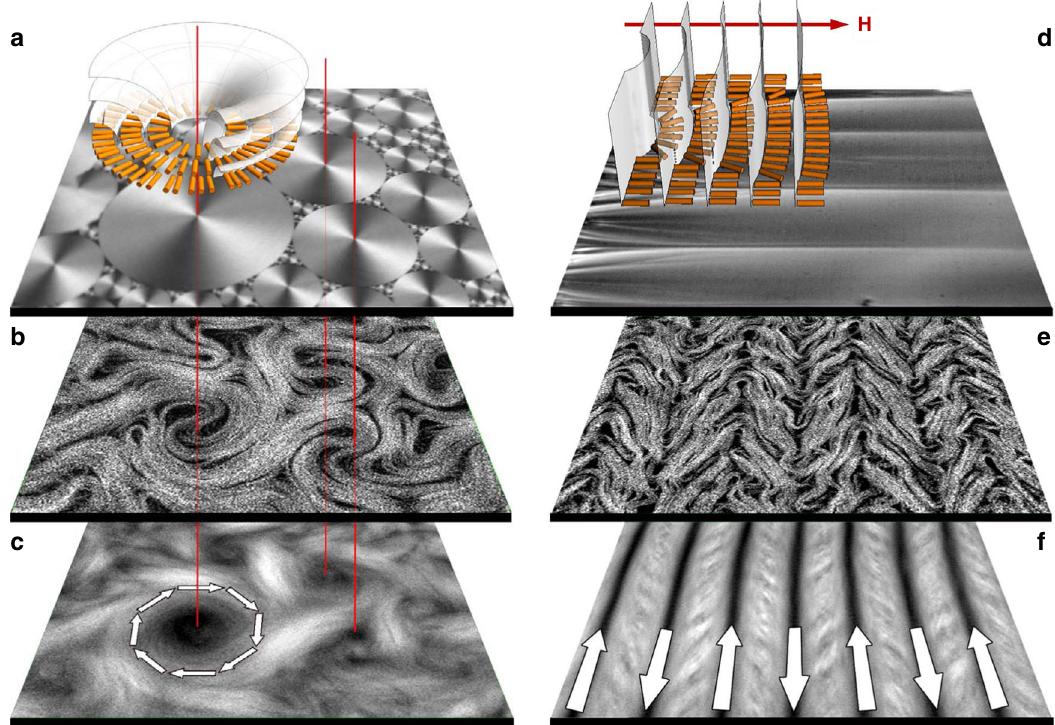
Fig. 2 Alignment of an active nematic by anisotropic soft interfaces. In a – c the active nematic is in contact with an unconstrained smectic-A phase. In d – f , an external magnetic fi eld ( H ) has aligned the smectic-A. In a and d the confocal re fl ection micrographs show the structure of the smectic-A phase at the interface with the aqueous phase in each case. The diagrams are sketches indicating the ordering of the smectic-A planes and liquid crystal molecules. b , e Fluorescence confocal micrographs of the active nematic layer with dynamical patterning that results from contact with the anisotropic interface. c , f Time averaged fl uorescence confocal micrographs (total integration time 300 s). Arrows indicate the direction of the organised active fl ow. Field of view is 300 ×300 μ m 15,68 . (Adapted with permission from Nature Publishing Group and AIP